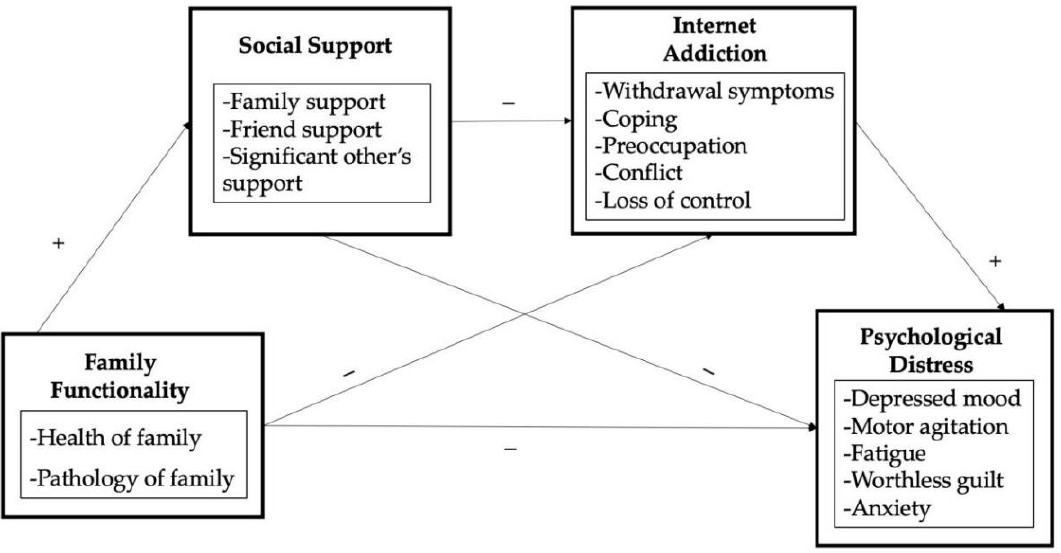
Figure 1. The theoretical